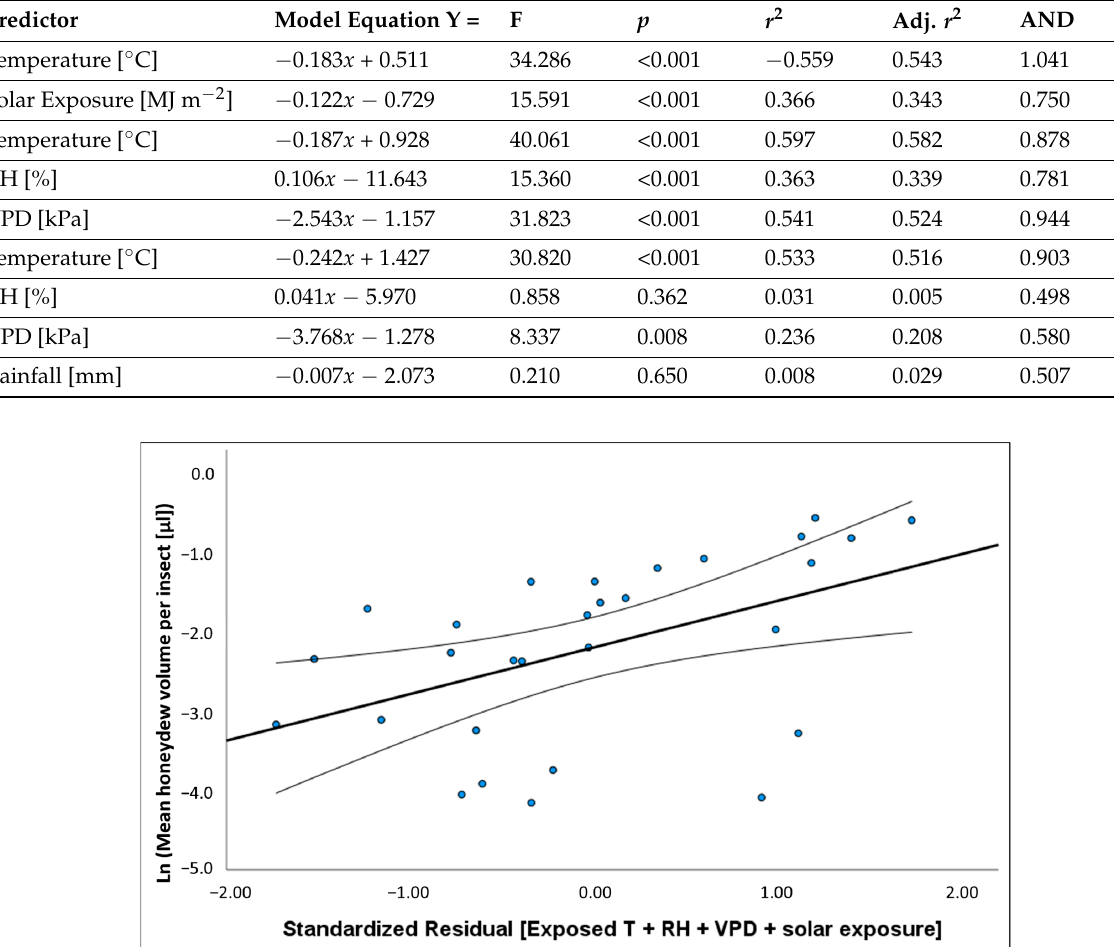
Table A12. Summary of climate regression models predicting log (mean volume of honeydew produced per M. hellenica sampled), with zeros removed. Climate records used in models represent the fortnightly mean value of daily maximum, except rainfall; recorded cumulatively in millimetres. N = 28. The absence of autocorrelation of the data is rejected if the Approximate Nonlinear Durbin- Watson (AND) statistic is less than 0.566 or greater than 2.098.